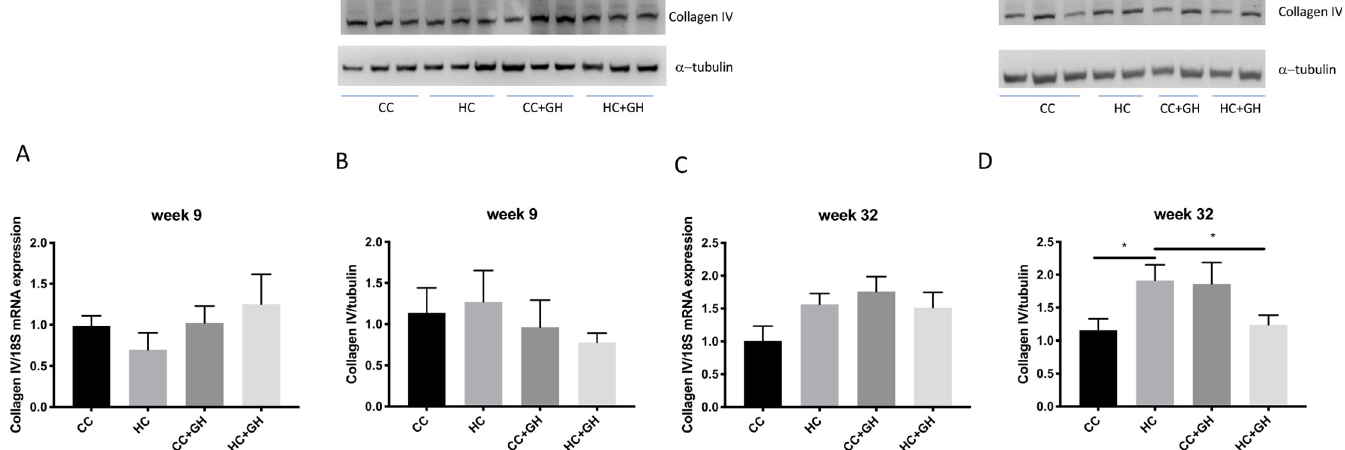
Fig 8. Renal fibrotic changes as measured by collagen IV. (A) Week 9 offspring mRNA expression of collagen IV, (B) week 9 offspring western blotting for collagen IV, (C) week 32 offspring mRNA expression of collagen IV, (D) week 32 offspring western blotting for collagen IV. Results expressed as mean ± SEM, n = 6. � p < 0.05.